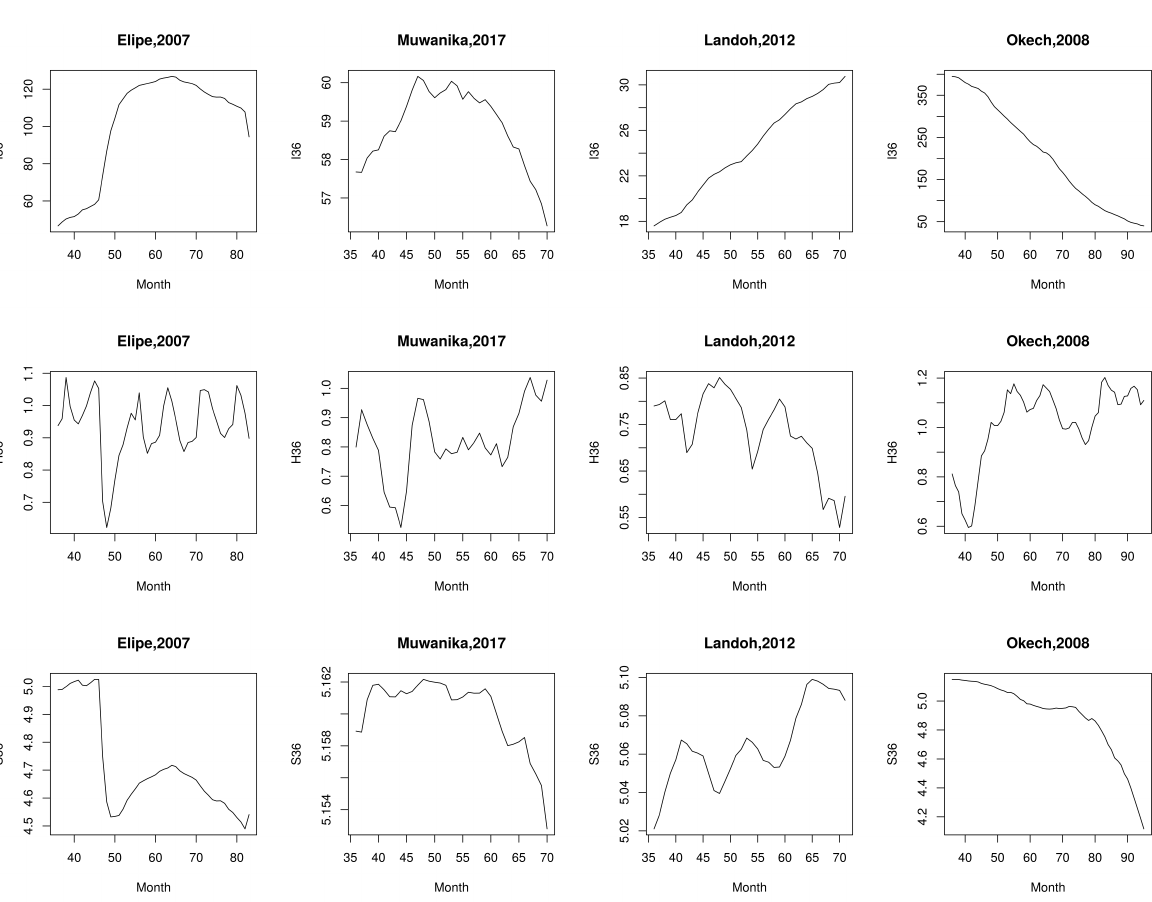
Figure A3. Comparative depiction of I 36 (top), H 36 (middle) and S 36 (bottom) for (from left to right) Alhassan et al. (Kasena Nankana municipality in Ghana, 2017) [21], Appiah et al. (Ejisu- Juaben municipality in Ghana, 2015) [16], Bedane et al. (Kucha district in Ethiopia, 2016) [23], and Aregawi et al. (Ethiopia, 2014) [22].